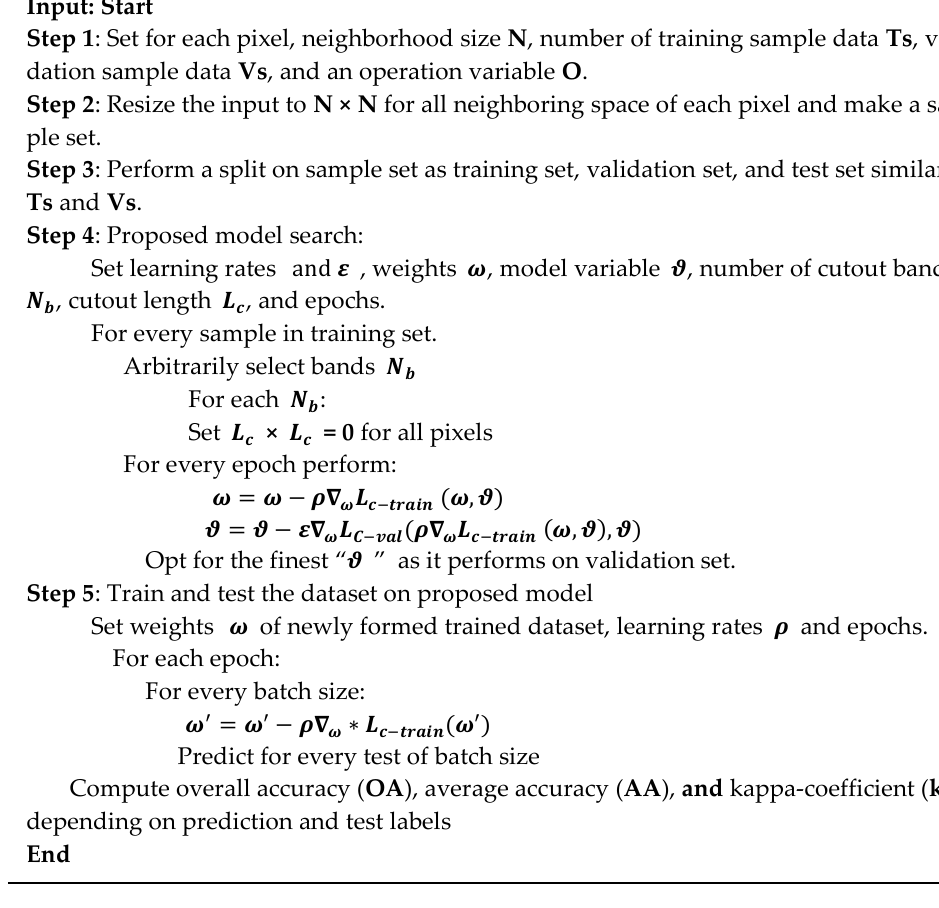
Algorithm 1: SE-AB-DenseNet with Cutout for HSI Spatial–Spectral Classification